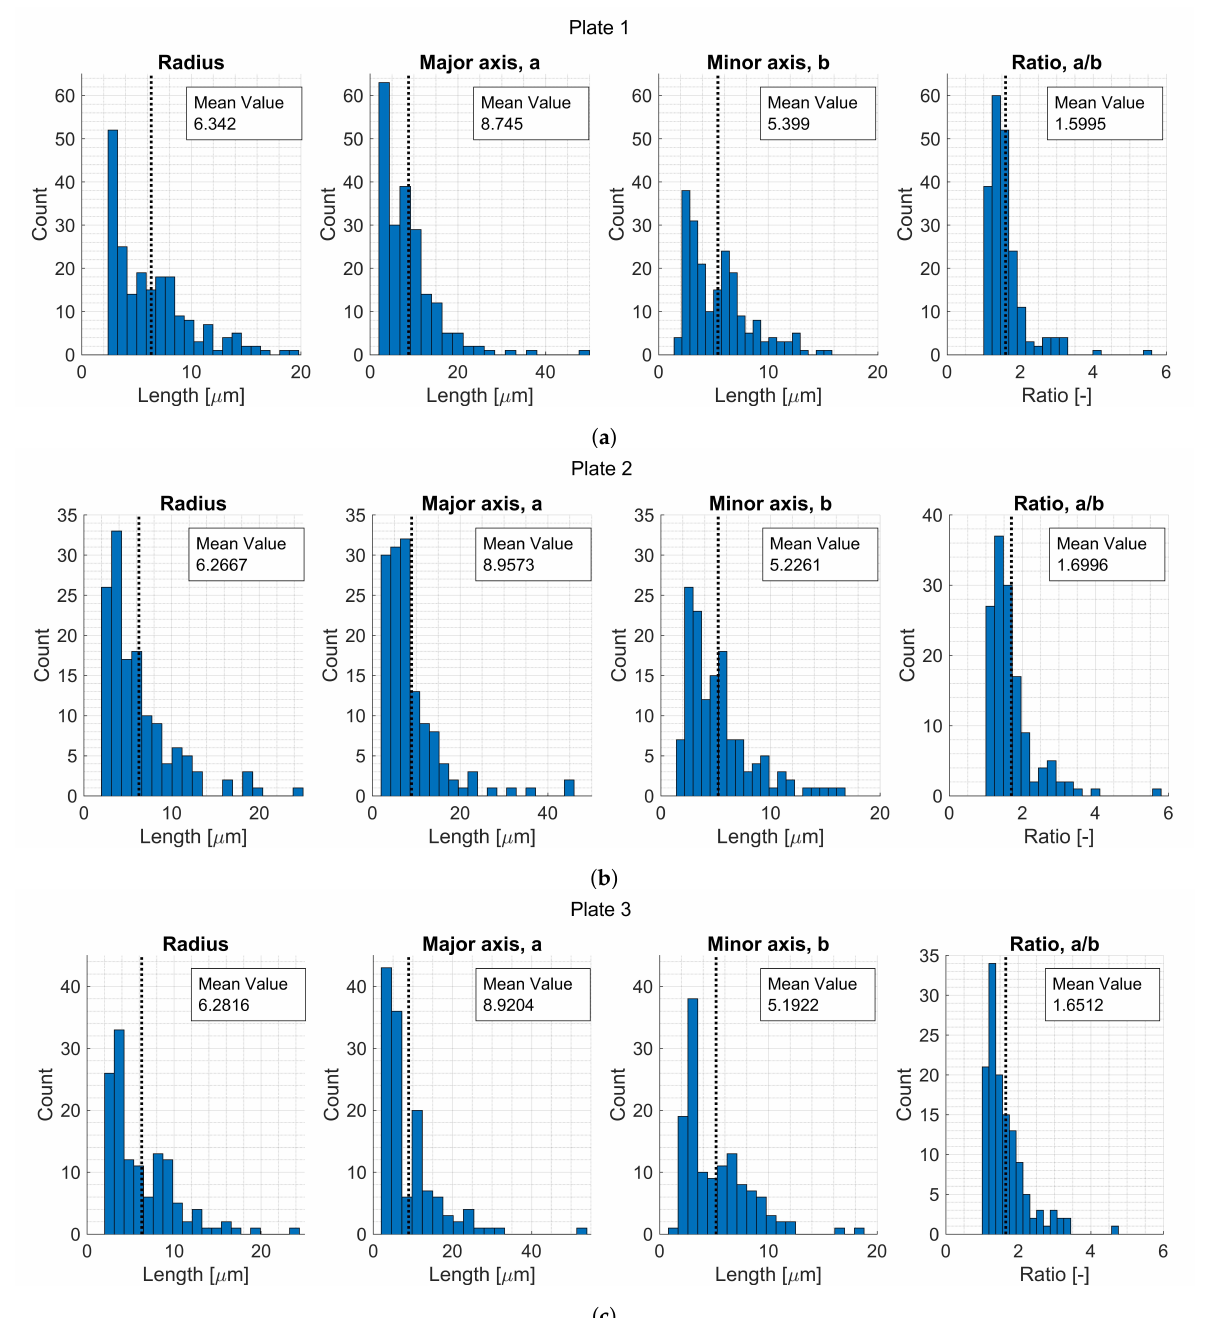
Figure 13. Histograms for void data variables for ( a ) Plate 1, ( b ) Plate 2, and ( c ) Plate